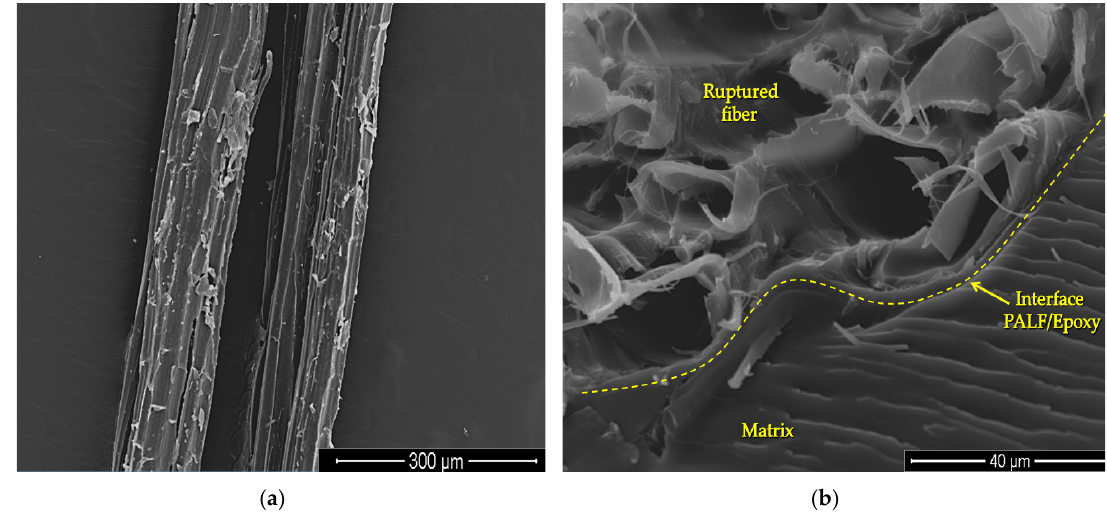
Figure 5. Scanning electron microscopy ( SEM) images of PALF morphology: ( a ) rough surface; ( b ) interface adhesion between PALF and epoxy matrix.